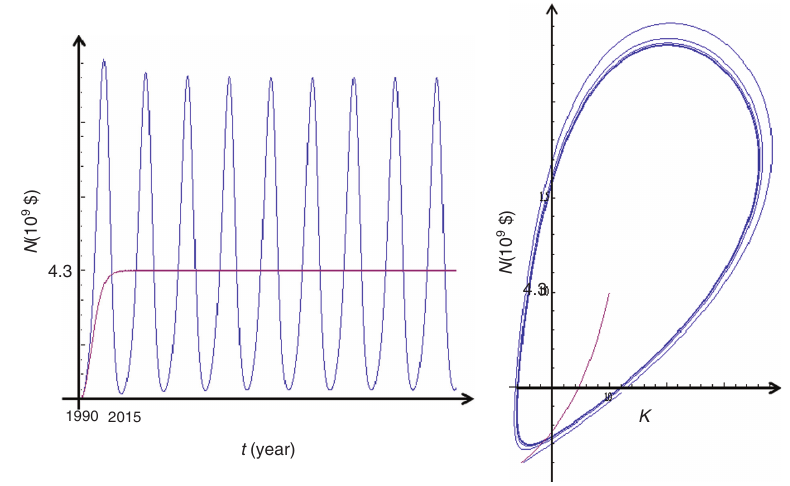
Figure 5 Delay of 3.75 years causing very large amplitude